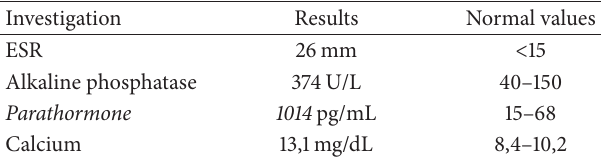
Figure 5: Systemic correlation. (a and b) A CT scan of the left knee highlighted the presence of an osteolytic, cyst-like, polylobate lesion which resembles those encountered in the mandible. (c) “Salt-and- pepper” appearance of the cranial vault. Table 1: Blood chemistry analysis. Bone metabolism was altered, parathormone was critically raised, and the calcium levels posed a high risk of heart failure.